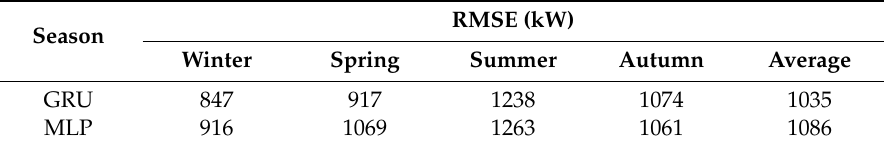
Table 15. Comparison between GRU and multilayer perceptron (MLP). Season